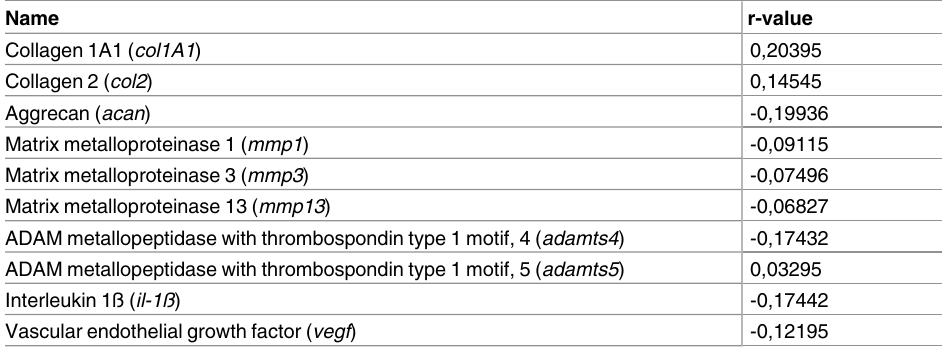
Table 2. Correlation gene expression vs histology. Correlation(r-values)of the geneexpressionfindings with the scored